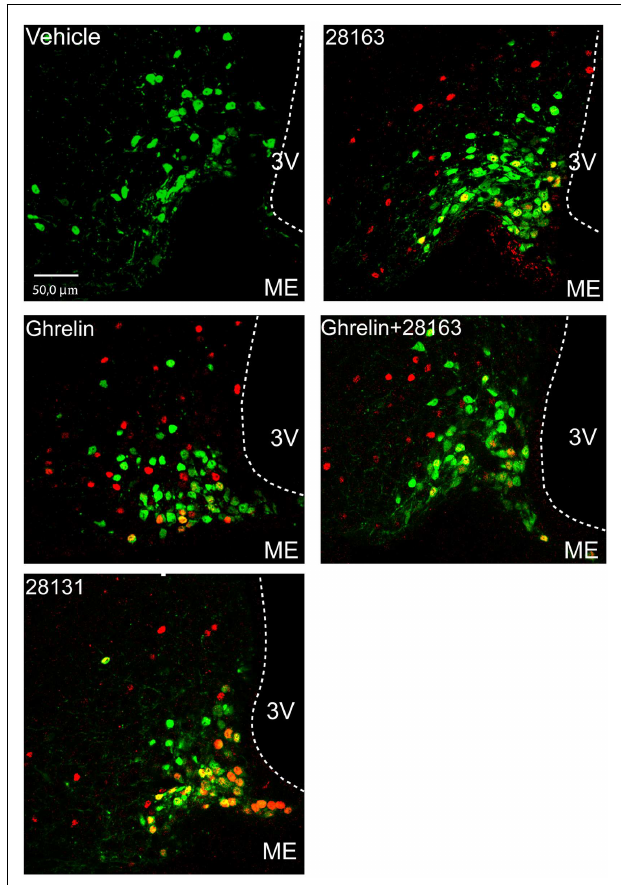
FIGURE 4 | Effect of native ghrelin and BIM compounds on cFos immunoreactivity inArcN NPY neurons in NPY-Renilla GFP mice. Representative confocal microphotographs showing GFP neurons (green), cFos nuclei (red), and the merge of both signals (yellow/orange) in coronal sections of the ArcN at approximately 2.1–1.9mm anterior to the interaural line. Data represent mean ± SEM. Scale bar represents 50 µ m in the ArcN. 3V, third ventricle; ME, median